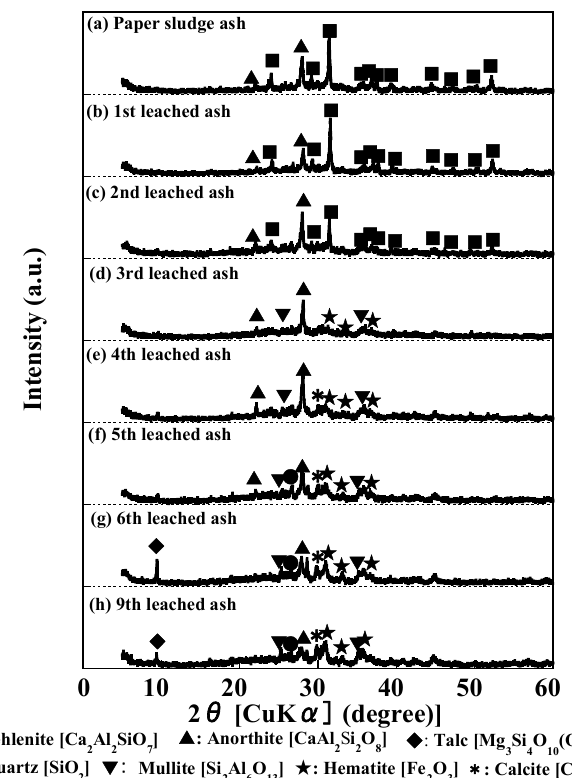
Figure 1. XRD patterns of ashes leached with 1 M HCl solution, as a function of the number of leaching treatments.